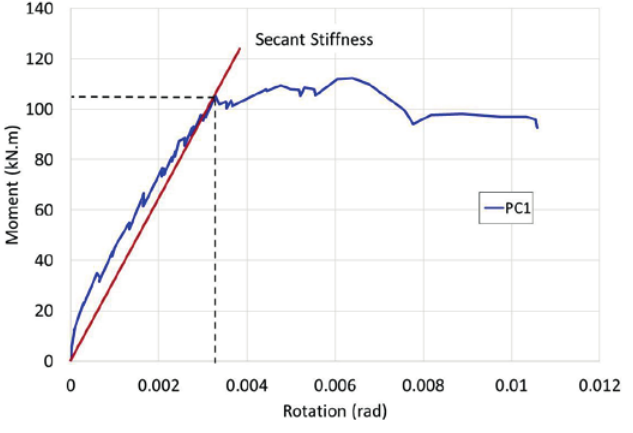
Figure 23 – Moment-rotation curve: specimens PC1 and PC2